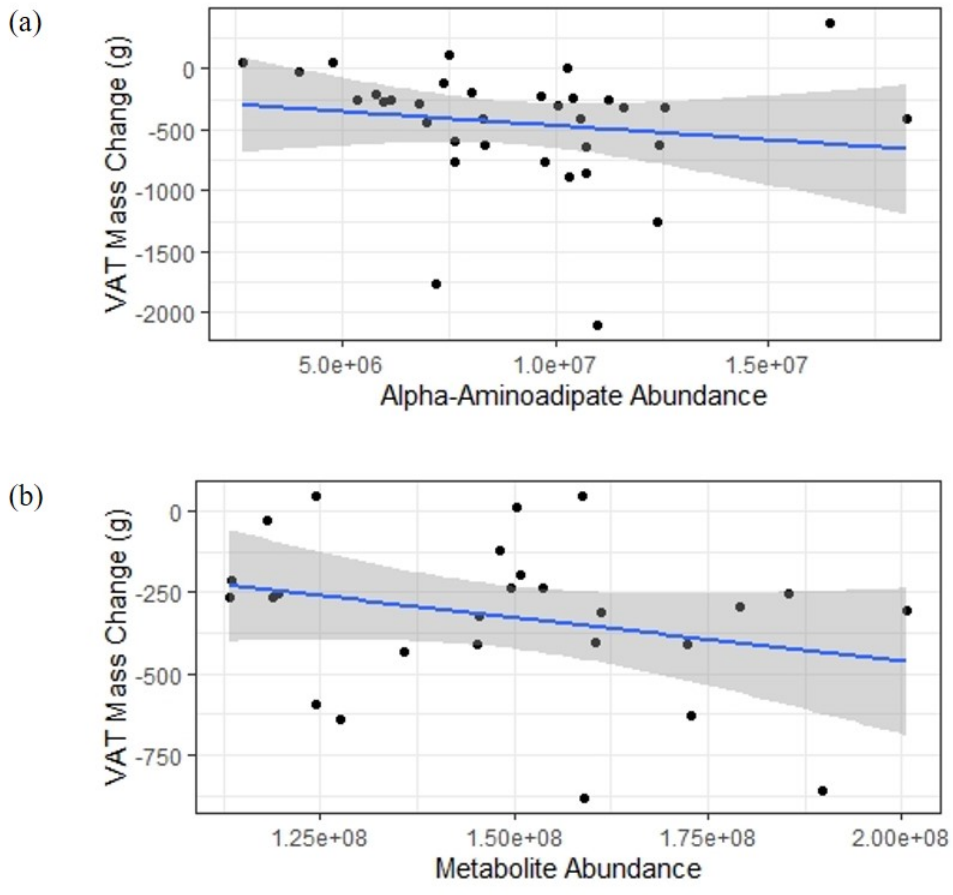
Figure 4. Scatter plot of baseline metabolite abundance vs. change in visceral adipose tissue (VAT). ( a ) Abundance of α -aminoadipate at baseline in all individuals randomized to weight loss (WL) vs. VAT mass change in grams following the intervention; ( b ) Abundance of the indeterminate metabolite at baseline vs. VAT mass change for females in the WL group only.